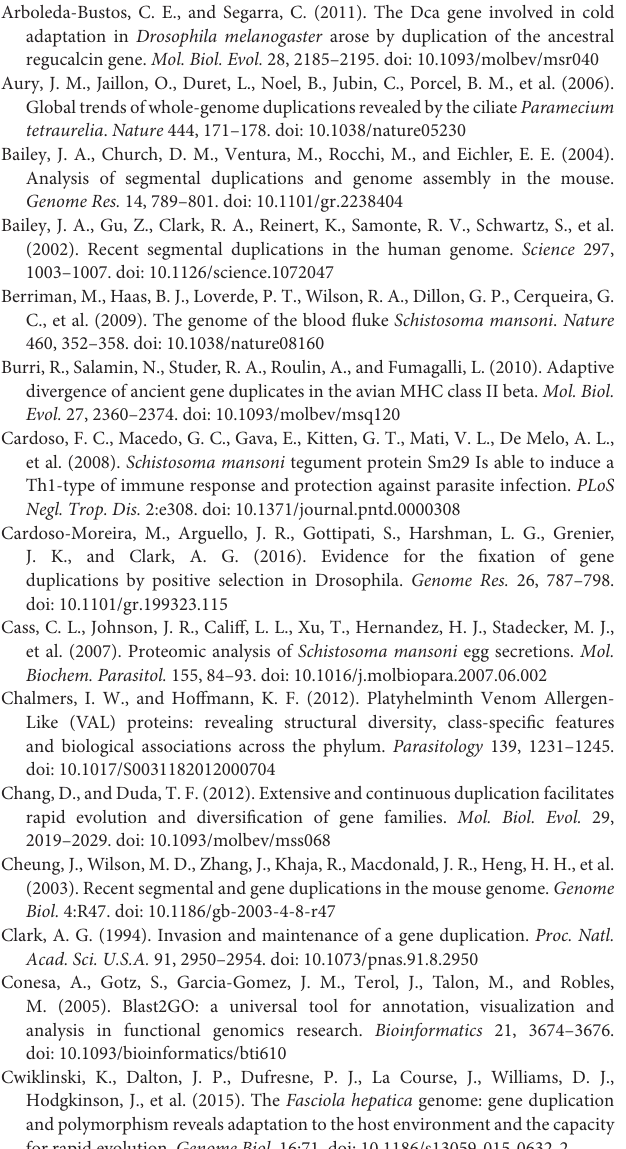
Supplementary Figure 3 | Ka and Ks values for paralogous pairs. The dots with different colors represent genes under positive selection (blue) and under negative selection (red). Supplementary Table 1 | Functional annotations of putative retrogenes and their parental genes.